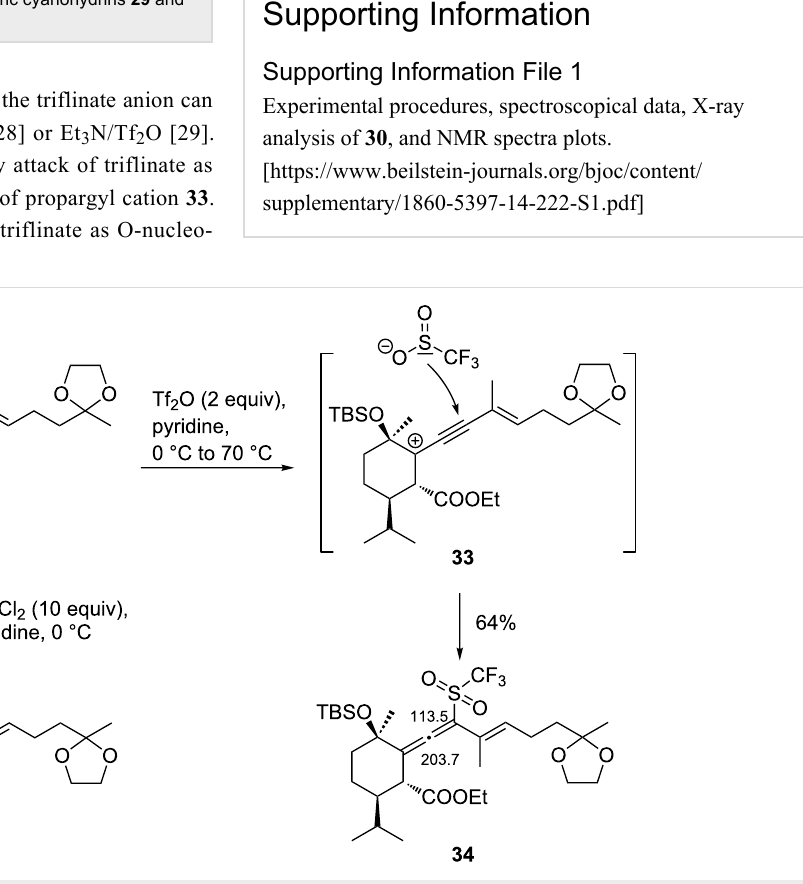
Scheme 5: Formation of allenes 32 and 34 from sterically crowded propargylic alcohol 31 .